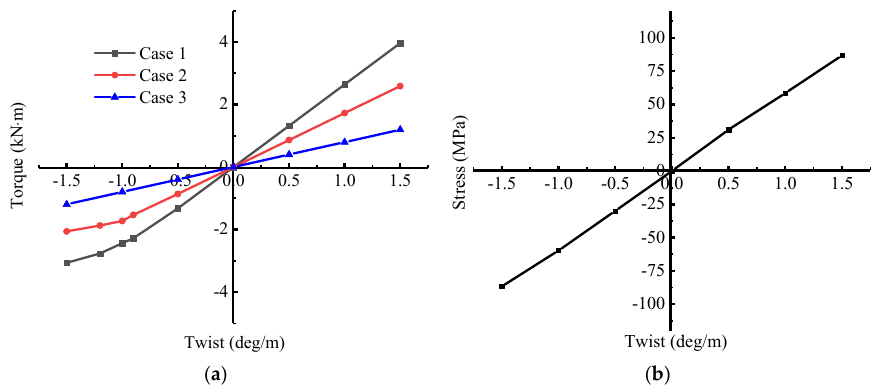
Figure 11. Torque and stress of 0° fiber versus twist per unit length. ( a ) Torque versus twist per unit length; ( b ) stress of 30° fiber versus twist per unit length.